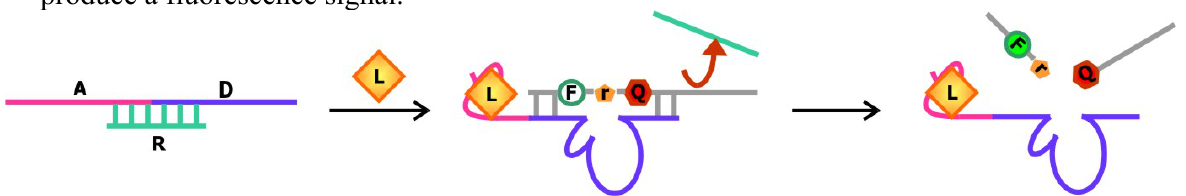
Figure 12. Aptazymes- using aptamer-deoxyribozyme constructs as biosensors [81].